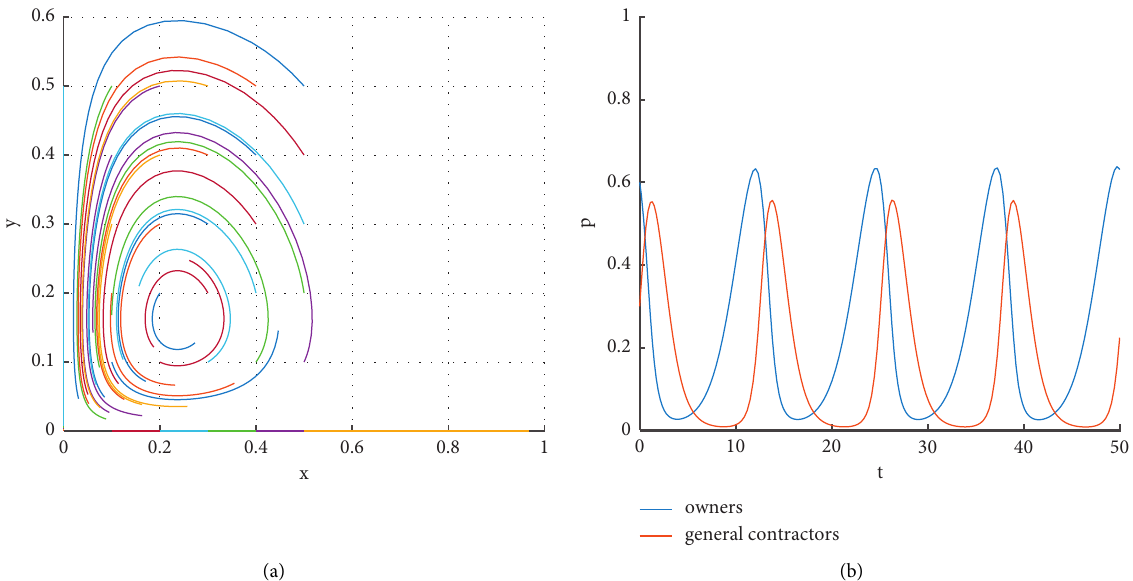
Figure 2: Dynamic evolution in Scenario 7. (a) Evolution path. (b) Evolution with x